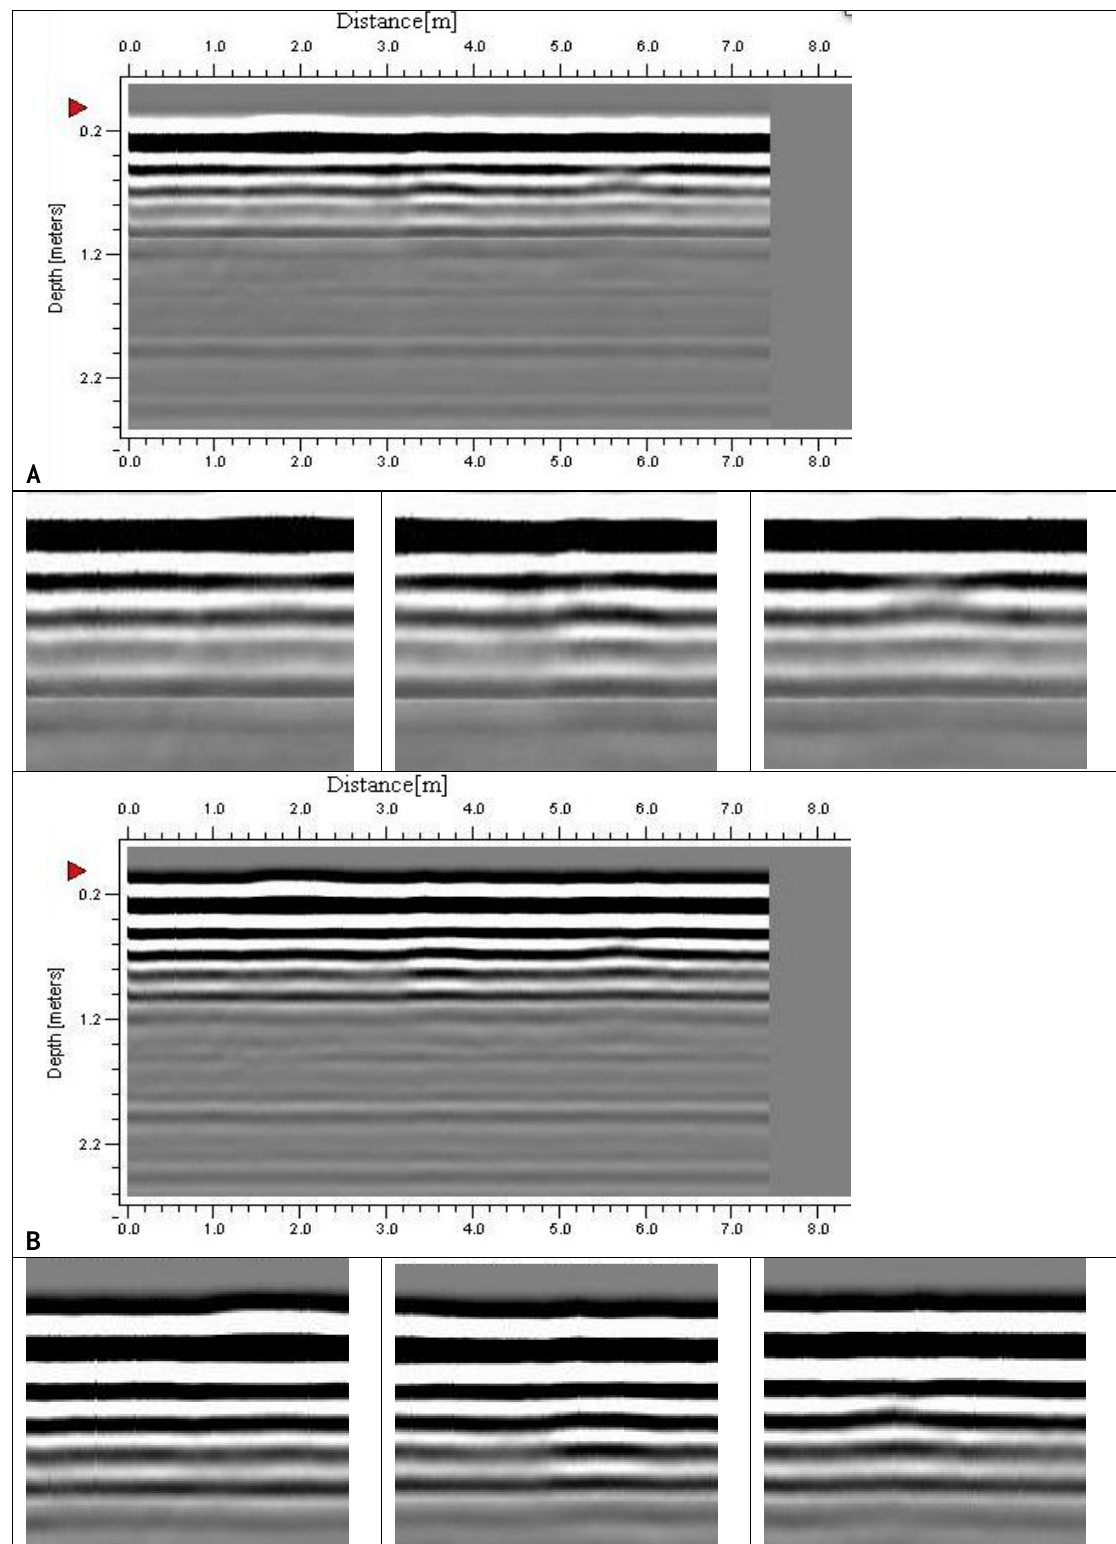
Fig.5: The filtered image with zooming of each buried objects A) apply dc adjustment filter. B) Apply FIR